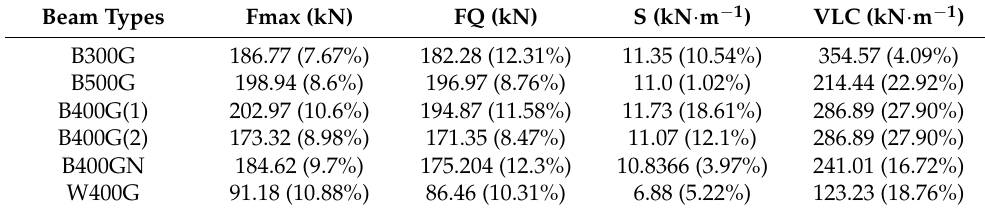
Figure 3. Typical load–displacement curve of test specimens. Table 3. Experimental parameters of different I-beams.